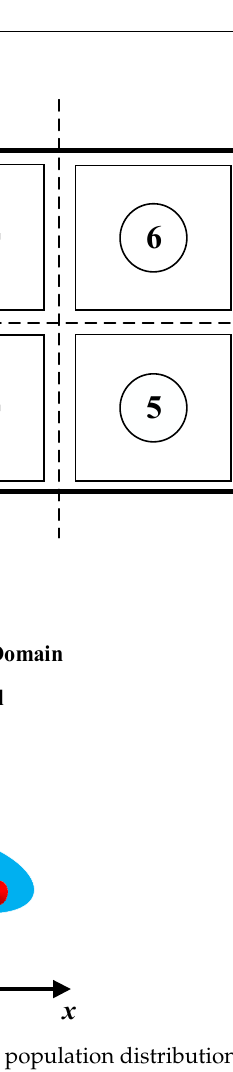
Allocation situation Fuzzy output Defuzzification